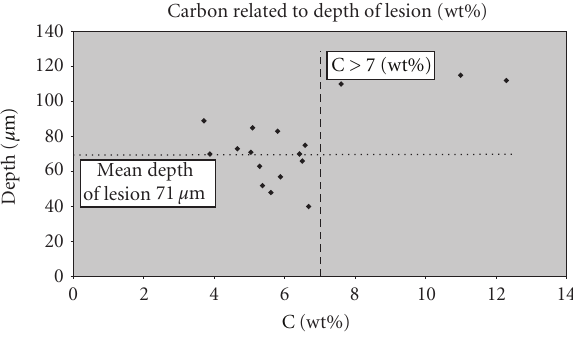
Figure 6: Plot of the wt% of carbon related to depth of lesion. Circle marks the specimen with wt% of carbon > 7%. which also have deeper lesion.